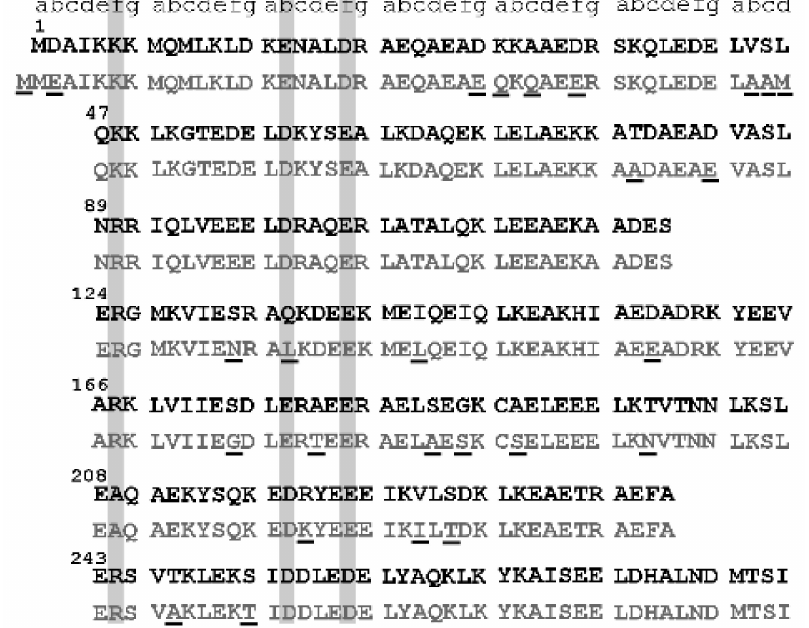
Figure 7. Comparison of amino acid sequences of Tpm1.1 (black) and Tpm3.12 (gray). Amino acid residues corresponding to heptapeptide repeat of the coiled coil (a–g) are shown on top of the sequences. The consensus sites which potentially interact with residues exposed on actin surface [46] are marked with gray boxes. Amino acid residues, which distinguish Tpm3.12 from Tpm1.1 are